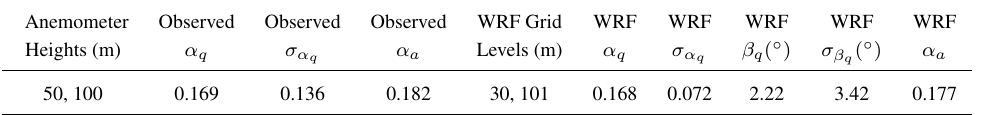
Table 4. Means and standard deviations of the observed and the WRF-NCAR model forecast-derived annual average shear exponents and directional shear magnitudes at Sweetwater, TX. Study period: April, 2006 – March, 2007. Anemometer Observed